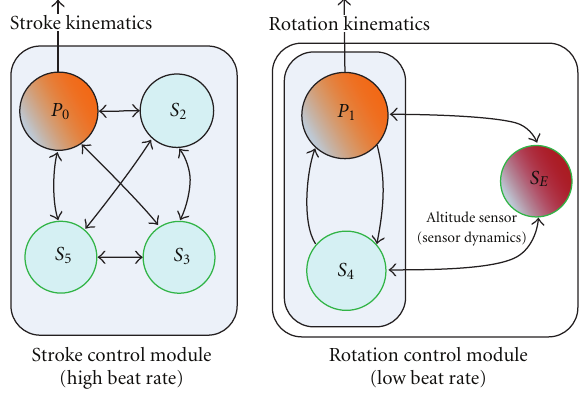
Figure 31: The Qualitative functional decomposition template derived for the non-autonomous cruise mode controllers. Most of the nonautonomous cruise mode controllers can be decomposed into the above-shown template, as a combination of two indepen- dent oscillator, of which the high-frequency oscillator, controlled the stroke kinematics of the wing with steady amplitude and frequency and the low-frequency oscillator which was evolved to monitor the altitude variations in the MFWR, through the available external sensor module, altered the rotation dynamics continuously to limit the variations in the altitude of the MFWR and simultane- ously provided the forward motion in it, by generating required lift and anti-lift with the behavior verified by the general principles of the empirical